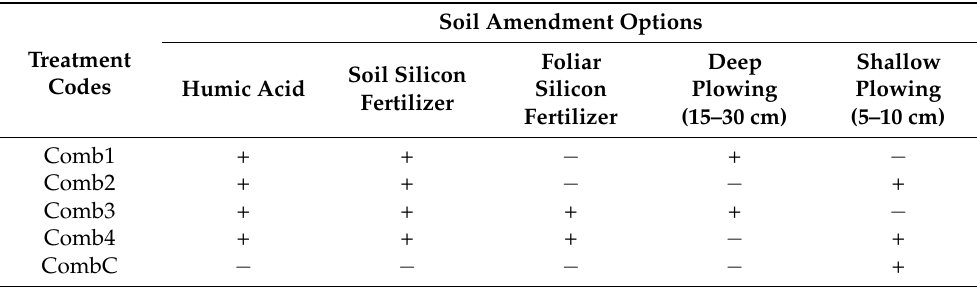
Table 2. The basic physicochemical properties of the soil before the addition of amendments.